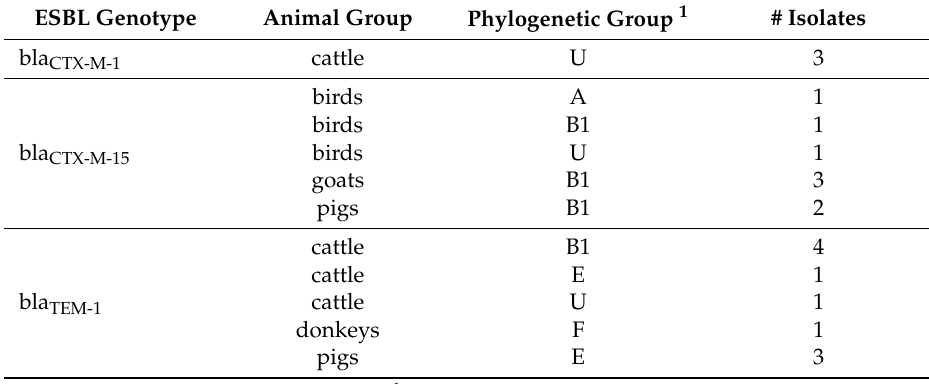
Table 4. Distribution of phylogenetic subgroups among broad- and extended-spectrum β -lactamase E. coli genotypes isolated from the feces of petting zoo animals ( n = 9). ESBL Genotype Animal Group Phylogenetic Group